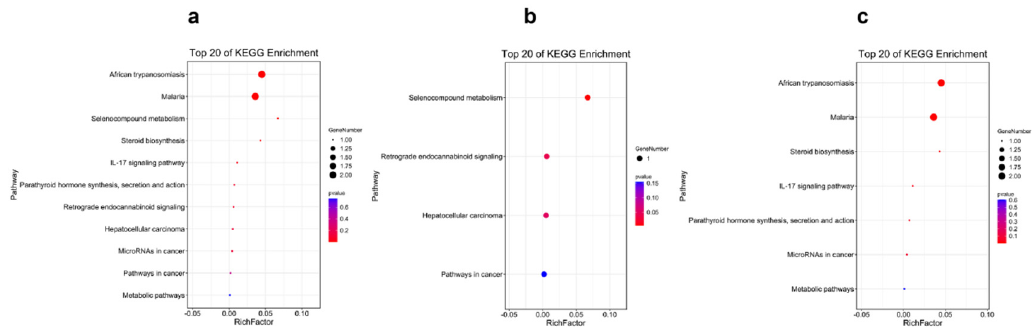
Figure 4. The Top 20 KEGG Pathways Enriched by the Differentially Expressed Genes in the Liver at 48 h Postinjection: ( a ) the Top 20 Enrichment Pathways among All Differentially Expressed Genes; ( b ) the Top 20 Enrichment Pathways among the Upregulated Differentially Expressed Genes; ( c ) the Top 20 Enrichment Pathways among the Downregulated Differentially Expressed Genes.